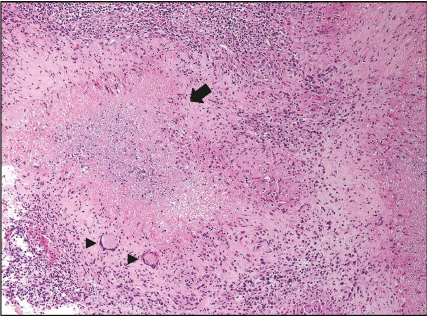
Figure 4: Intraoperative histopathological examination (hematoxylin- eosin stain, × 4). Arrow: caseous necrosis. Arrowhead: Langerhans giant